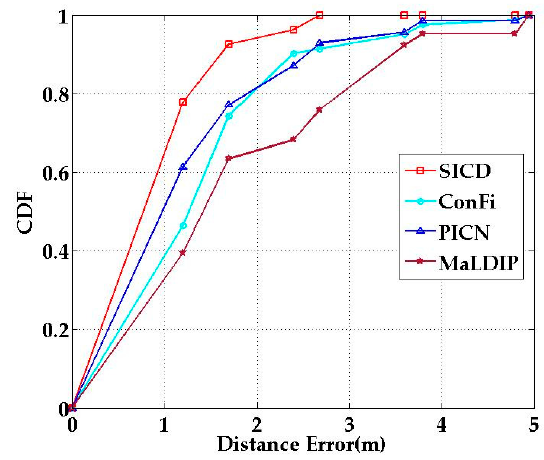
Figure 14. Cumulative distribution function (CDF) of localization errors with different methods.